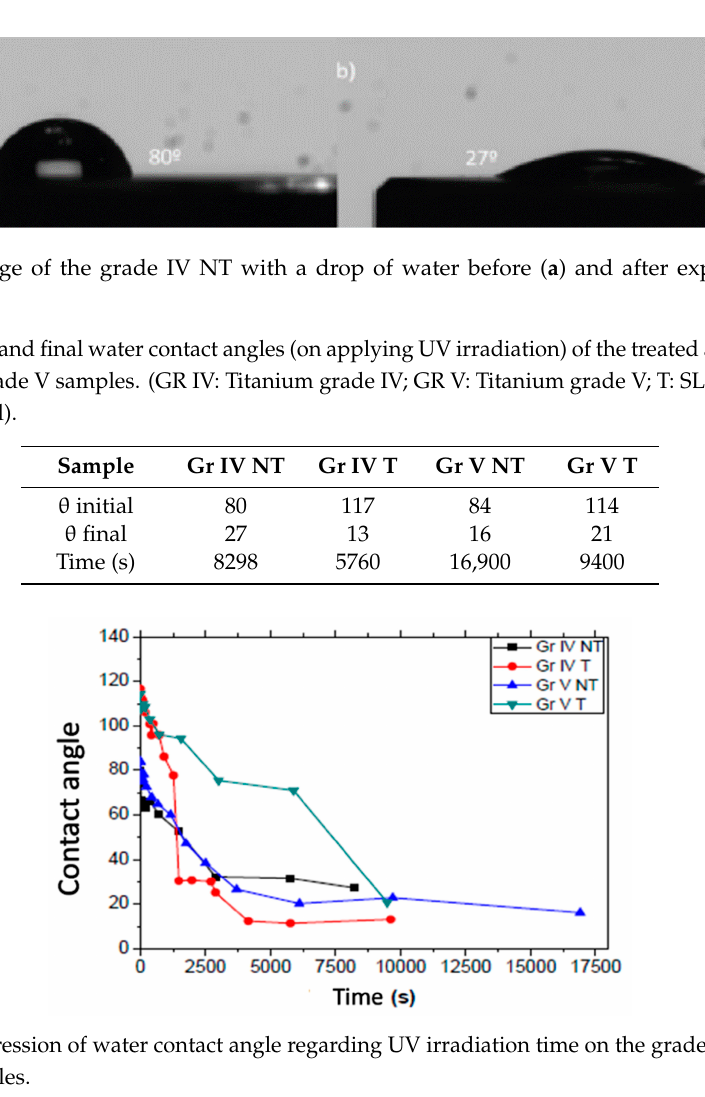
Figure 12. Progression of water contact angle regarding UV irradiation time on the grade IV and grade V original samples.